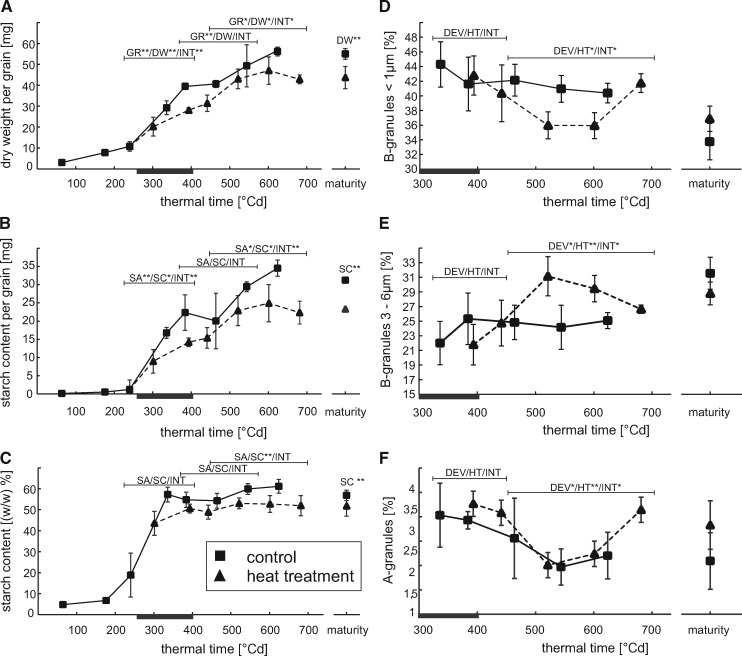
The impact of a heat wave during the grain filling period on starch accumulation and starch granule size distribution in barley cultivar Quench. The duration of the heat wave is indicated by a black bar on the abscissae of each graph. Squared symbols represent data points from plants grown under control conditions, while triangles represent plants that suffered from exposure to a heat wave between days 16 and 21 after anthesis. Time is shown as thermal time (�Cd) to facilitate comparison between the two curves shown. Samples were taken during grain filling as well as from mature plants that underwent complete senescence. (A) Average grain weight in mg. (B) Starch content per grain in mg (C) Relative starch content of the grain [(w/w)%] (D) Proportion of B-granules <1�m (E) Proportion of B-granules 3–6�m (F) Proportion of A-granules. For samples taken during development (n = 3), for samples taken at maturity (n = 5). Starch granule measurements were made in 3 technical replicates per sample. The bars above the respective curves indicate ANCOVA analysis showing *P < 0.05 or **P < 0.01 significance. The symbols * and ** indicate the same significance thresholds for ANOVA analysis of the mature samples. GR, growth rate representing difference in grain weight over time of combined treatments; DW, dry weight representing differences in grain weight between treatments; SA, starch accumulation representing differences in starch content in thermal time of combined treatments; SC, starch content representing differences in starch content between treatments; DEV, difference in starch granule content over time of combined treatments; HT, difference in starch granule content between treatments; INT, interaction between changes over the indicated thermal time period and the applied treatment.